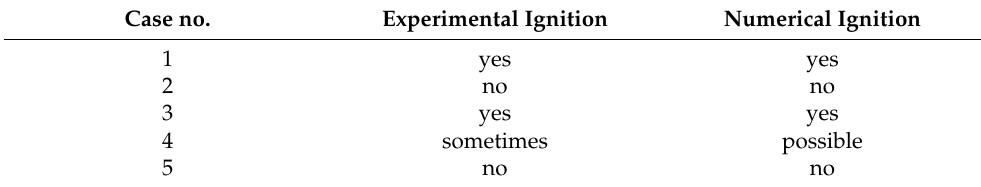
Table 3. Comparison of experimental and numerical results. Case